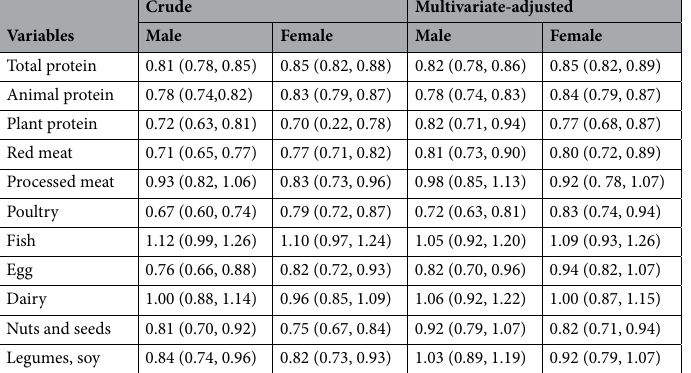
Table 4. Odds ratio for metabolic syndrome per each increment in the frequency of consumption of different protein sources stratified by sex. Adjusted for age (year), physical activity, current smoker, BMI, fruits, vegetables, cereal and protein